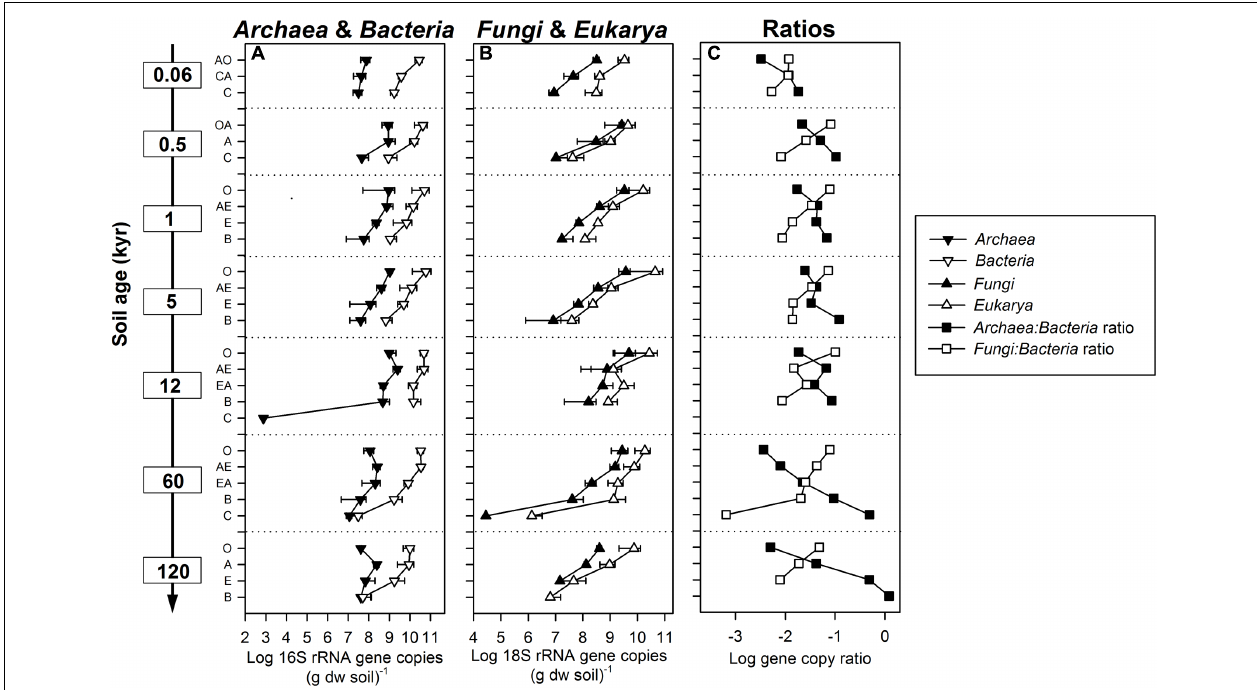
FIGURE 1 | Abundances of SSU rRNA gene copies in different soil horizons (O, OA, A, AO, AE, E, EA, B, C, CA) from depth profiles of 0.06, 0.5, 1, 5, 12, 60, and 120 kyr old soils along the Franz Josef chronosequence. (A) Archaea and Bacteria 16S (assay Nadkarni et al., 2002), and (B) Fungi and Eukarya 18S rRNA gene copy numbers per gram soil dry weight (dw). Error bars indicate standard deviation of three parallel soil profiles. (C) Ratio of archaeal to bacterial, and fungal to bacterial SSU rRNA gene copy numbers.